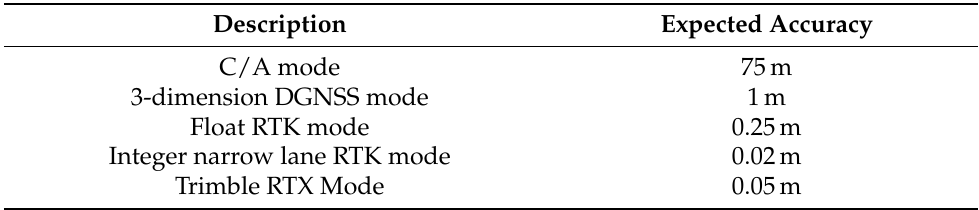
Table 3. The Description of position methods whose expected accuracy is provided as column names in Tables 1 and